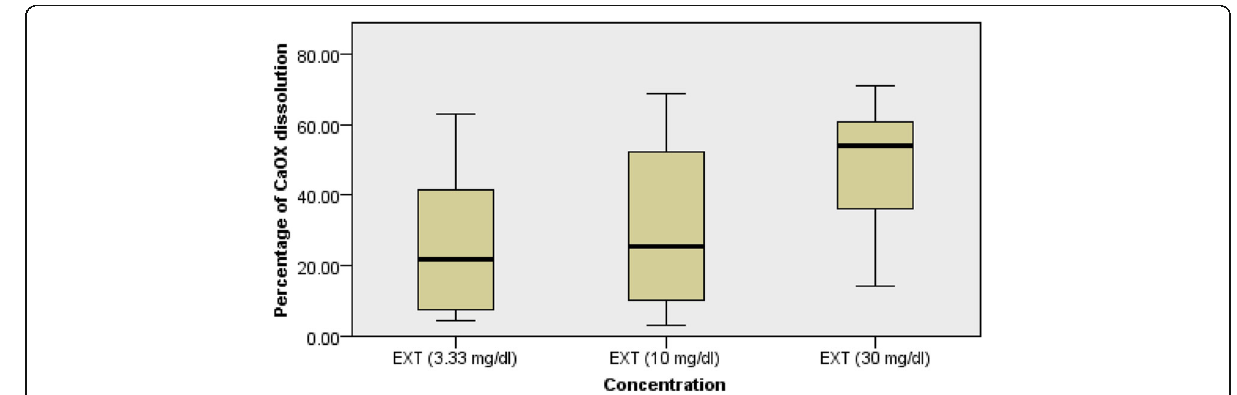
Fig. 3 Percent dissolution of oxalate calcium (CaOx) based on extract